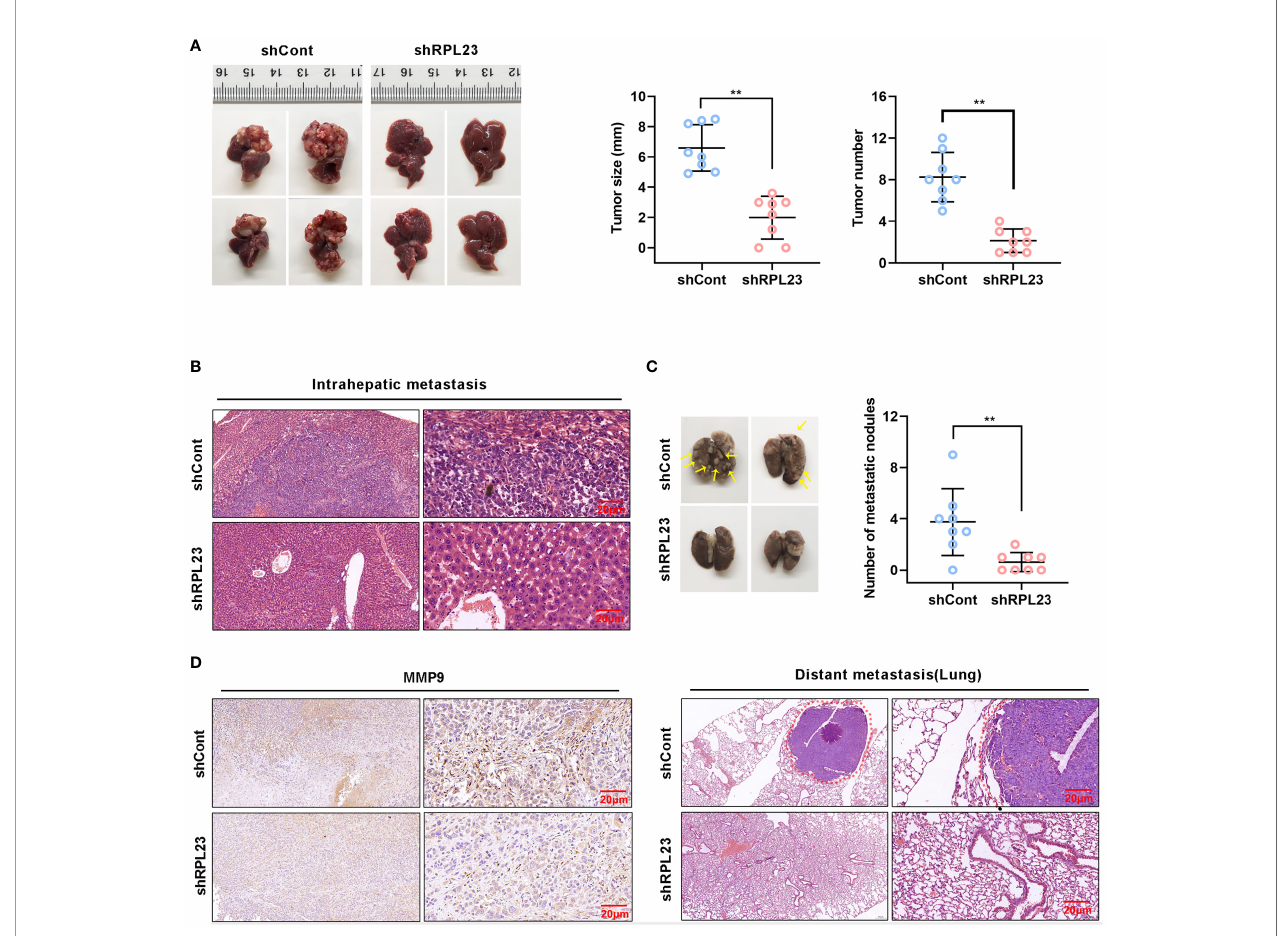
FIGURE 7 | RPL23 knockdown suppressed HCC cell lung metastasis in vivo . The nude mice were orthotopically injected with MHCC97H cells stably depleted RPL23. (A) Representative images (left), volume and number (right) of xenograft liver tumor in nude mice. (B) The presence or absence of metastatic nodules in the liver was evaluated by Hematoxylin-Eosin staining. (C) Representative images of lung metastasis nodules in different groups (up), and evaluated by Hematoxylin- Eosin staining(down). (D) IHC assay showed MMP9 expression in metastatic xenograft model tissue in different groups. For (A, C) , the data were presented as mean ± SD, n = 8 in each group. **P <